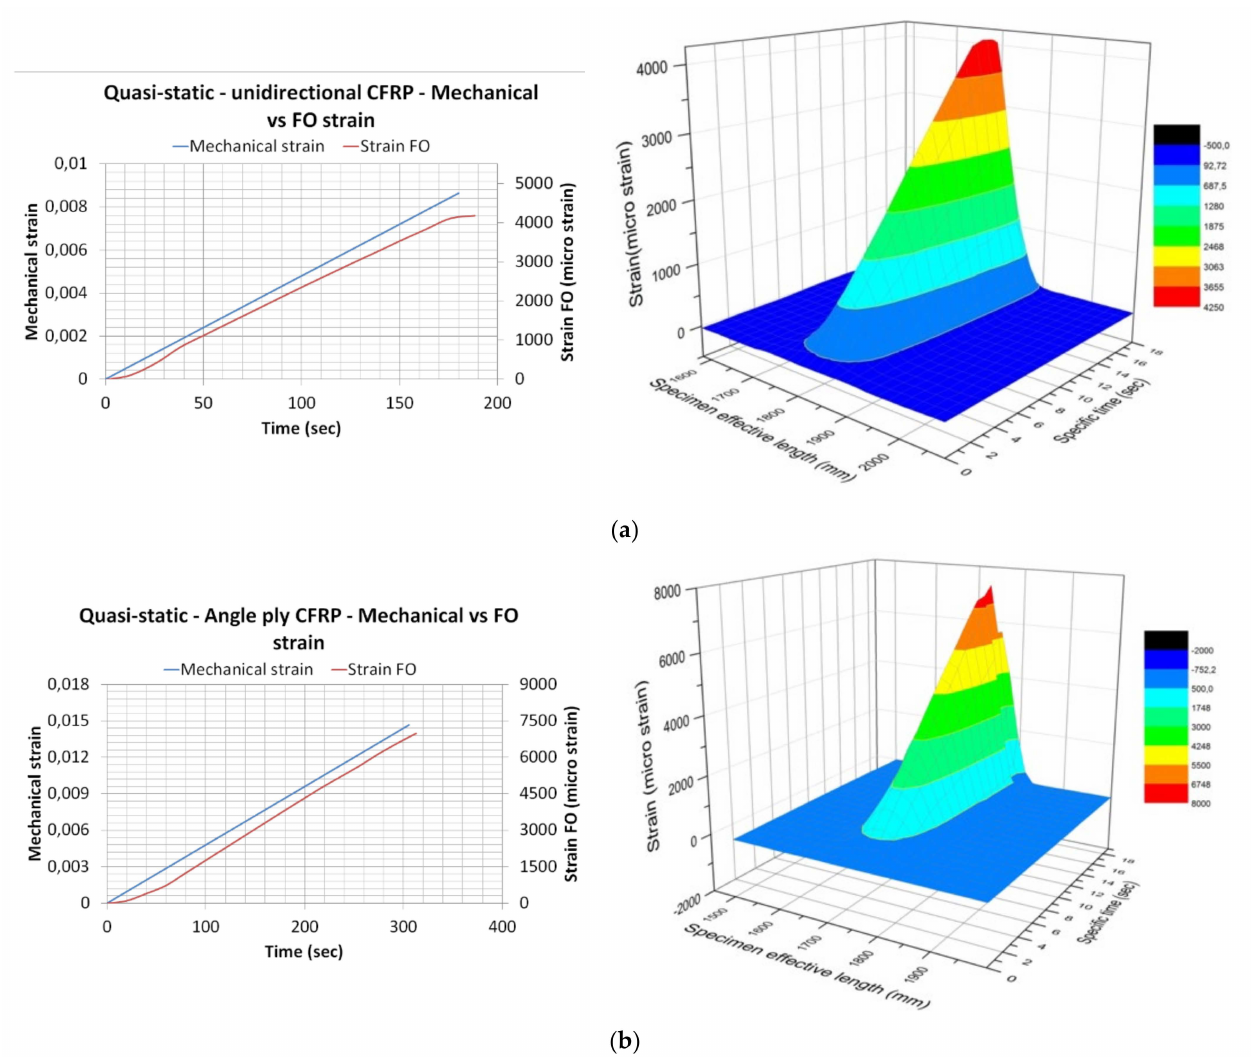
Figure 17. ( a ) Quasi-static test curve of UD smart specimen along with the 3-D curve of UD smart specimen. ( b ) Quasi-static test curve of angle-ply smart specimen along with the 3-D profile